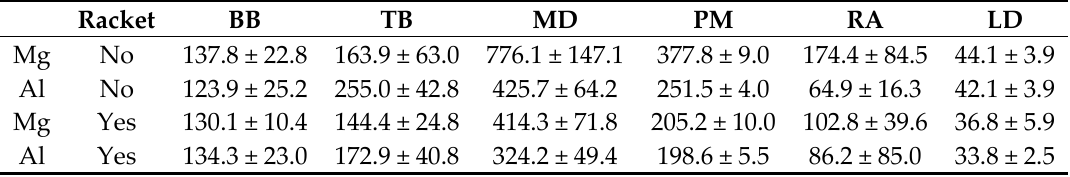
Table 1. Mean amplitude and standard deviation of mean amplitude for 20 s Dash (forward stroke).